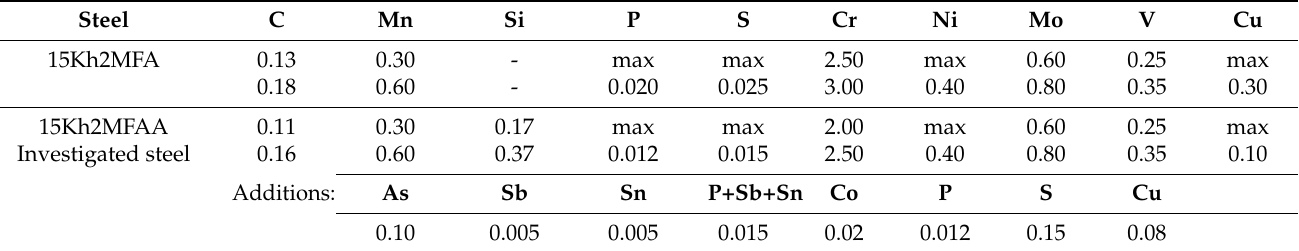
Table 1. Chemical composition (in wt.%) of 15Kh2MFA and 15Kh2MFAA RPV